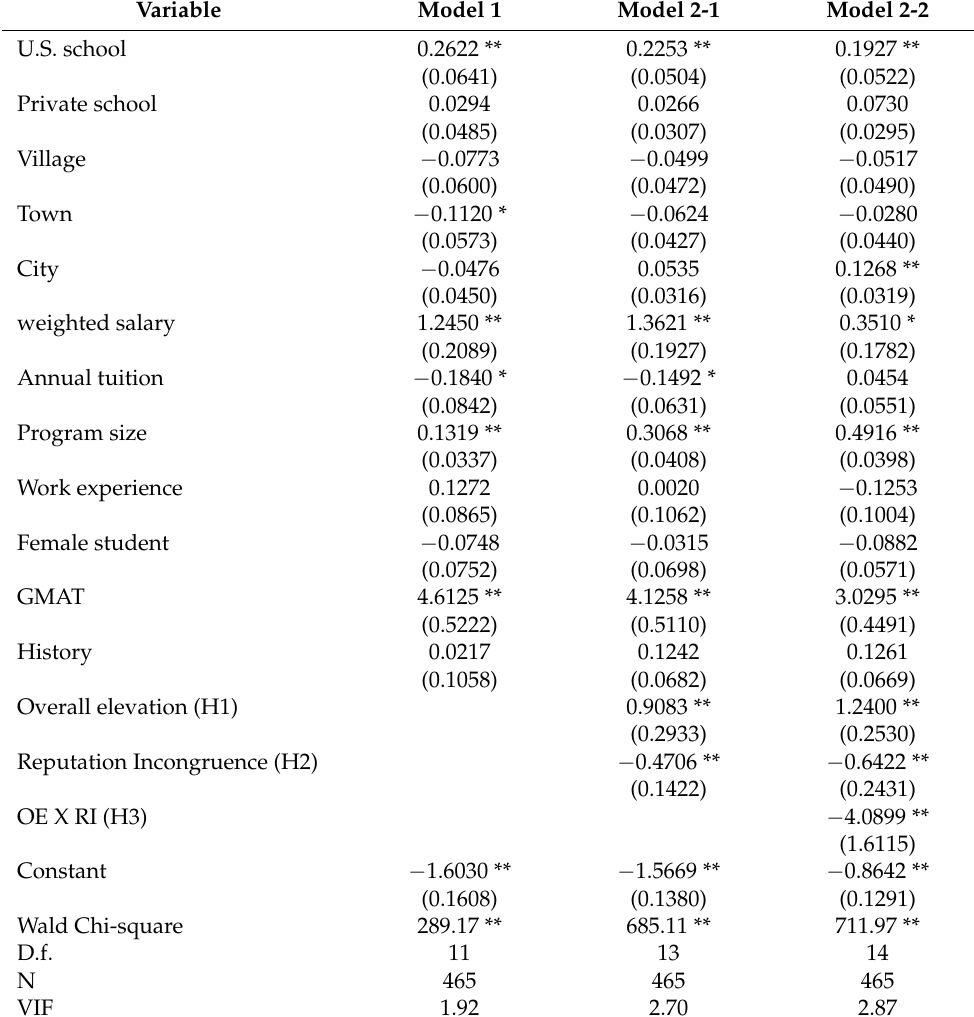
Table 4. GEE estimates of the number of applicants,